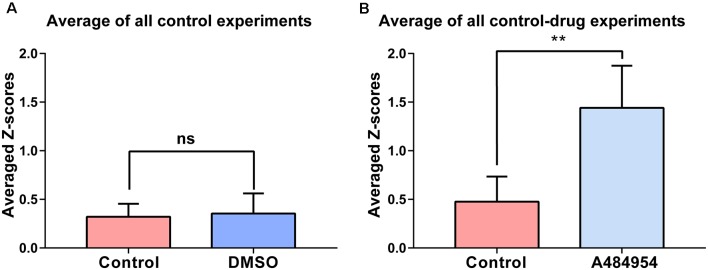
Synchronization level between different CA1 ROIs in response to DMSO or A484954. (A) The bar graph shows that DMSO (0.35 ± 0.07) did not alter the synchronization level between different CA1 areas in comparison with the control group (0.32 ± 0.05; n = 8, ns, unpaired t-test). (B) The bar graph shows that in all slices treated with A484954, the Z score—transformed PC values of the A484954 group (1.44 ± 0.15) were significantly increased compared with the control group (0.48 ± 0.09; n = 8, **P < 0.01, unpaired t-test).